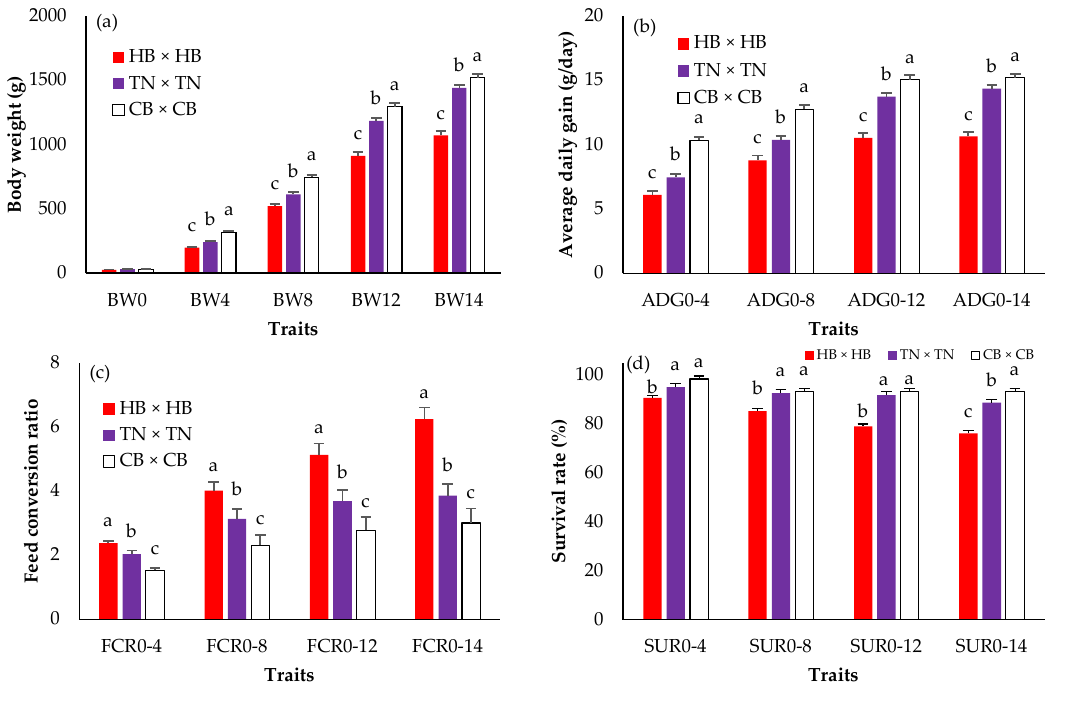
Figure 1. The least squares means (standard error) of the body weight ( a ); average daily gain ( b ); feed conversion ratio ( c ); survival rate ( d ) in purebred black-bone and Thai native chickens; a, b, c: Means for the trait with different letters differ significantly at p < 0.05; HB × HB — purebred Hmong black-bone chicken (red bar); TN × TN — purebred Thai native chicken (purple bar); CB × CB — purebred Chinese black-bone chicken (white bar); BW0—birth weight (g); BW4, BW4, BW8, BW12, BW14—birth weight and body weight at 4, 8, 12, 14 (slaughtering weight) weeks of age (g); ADG0–4, ADG0–8,